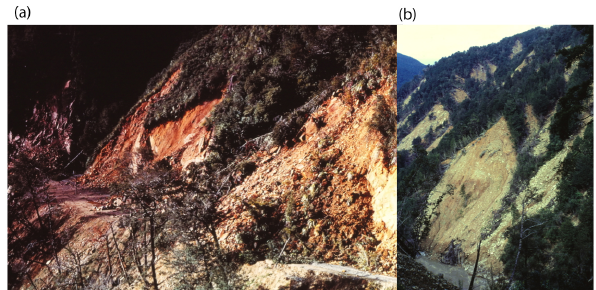
Figure 3. (a) 1968 debris slide on road cut in the upper Buller Gorge. (b) Multiple 1968 debris slides on slopes on the south side of the Buller River.